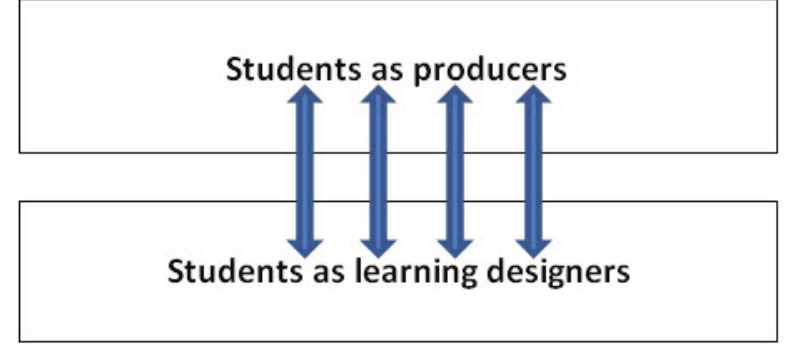
Figure 1: Interrelation between the complementary processes and roles